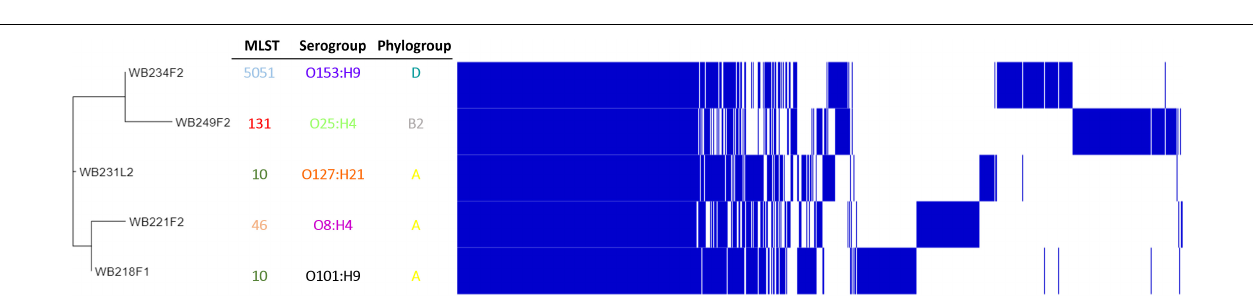
FIGURE 3 | Pangenome analysis of ES β L-producing Escherichia coli isolated from wild boars. The figure evidence, on the left, phylogenetic tree, built on SNPs of core genes. Identification of Sequence Type (MLST), serogroup, and phylogroup are also